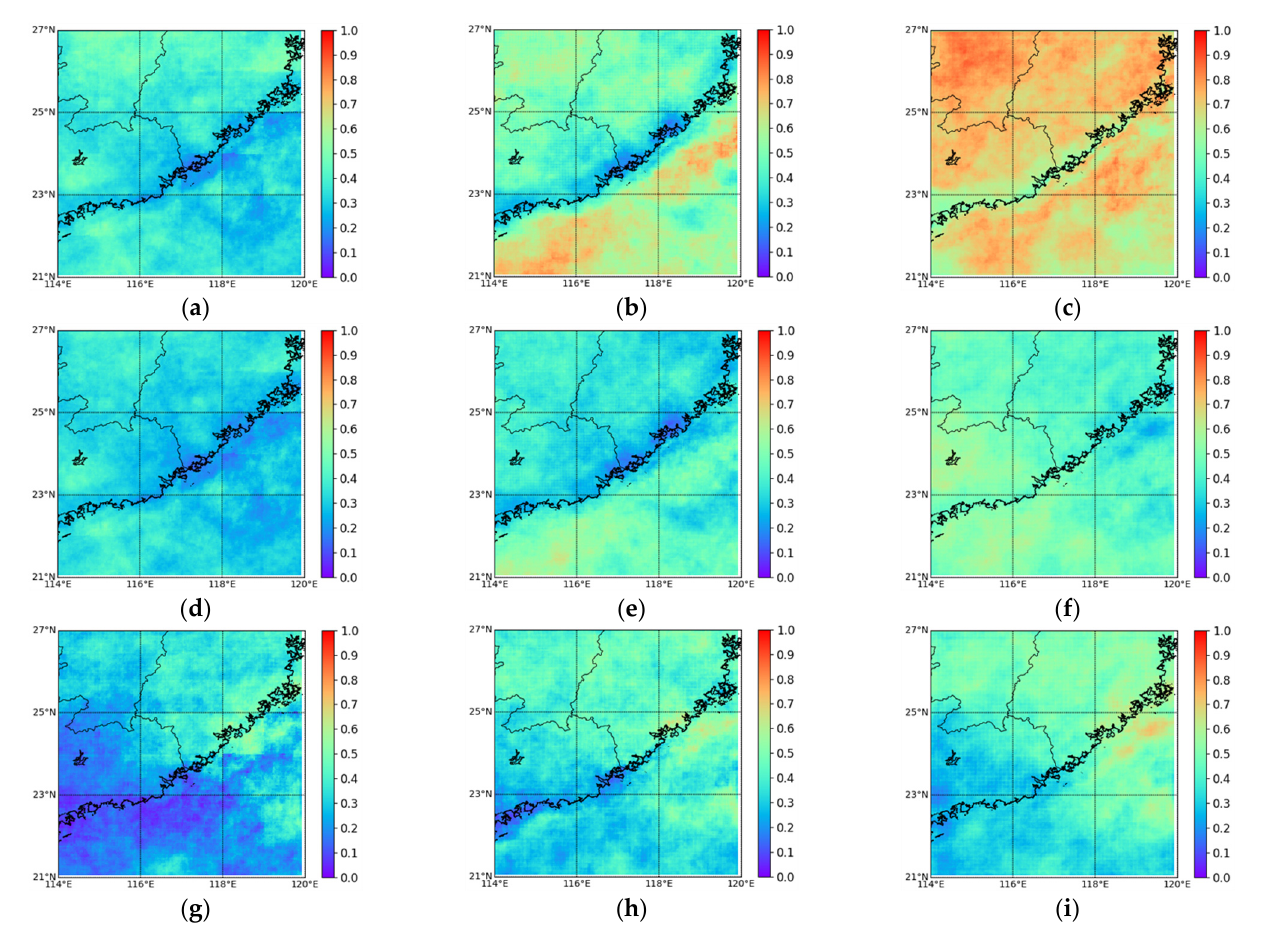
Figure 3. POD, CSI, and FAR of CMORPH, FY4A-QPE and Attention-Unet model over the south- eastern coast of China during the validation period (June–August 2020). ( a – c ) POD; ( d – f ) CSI;